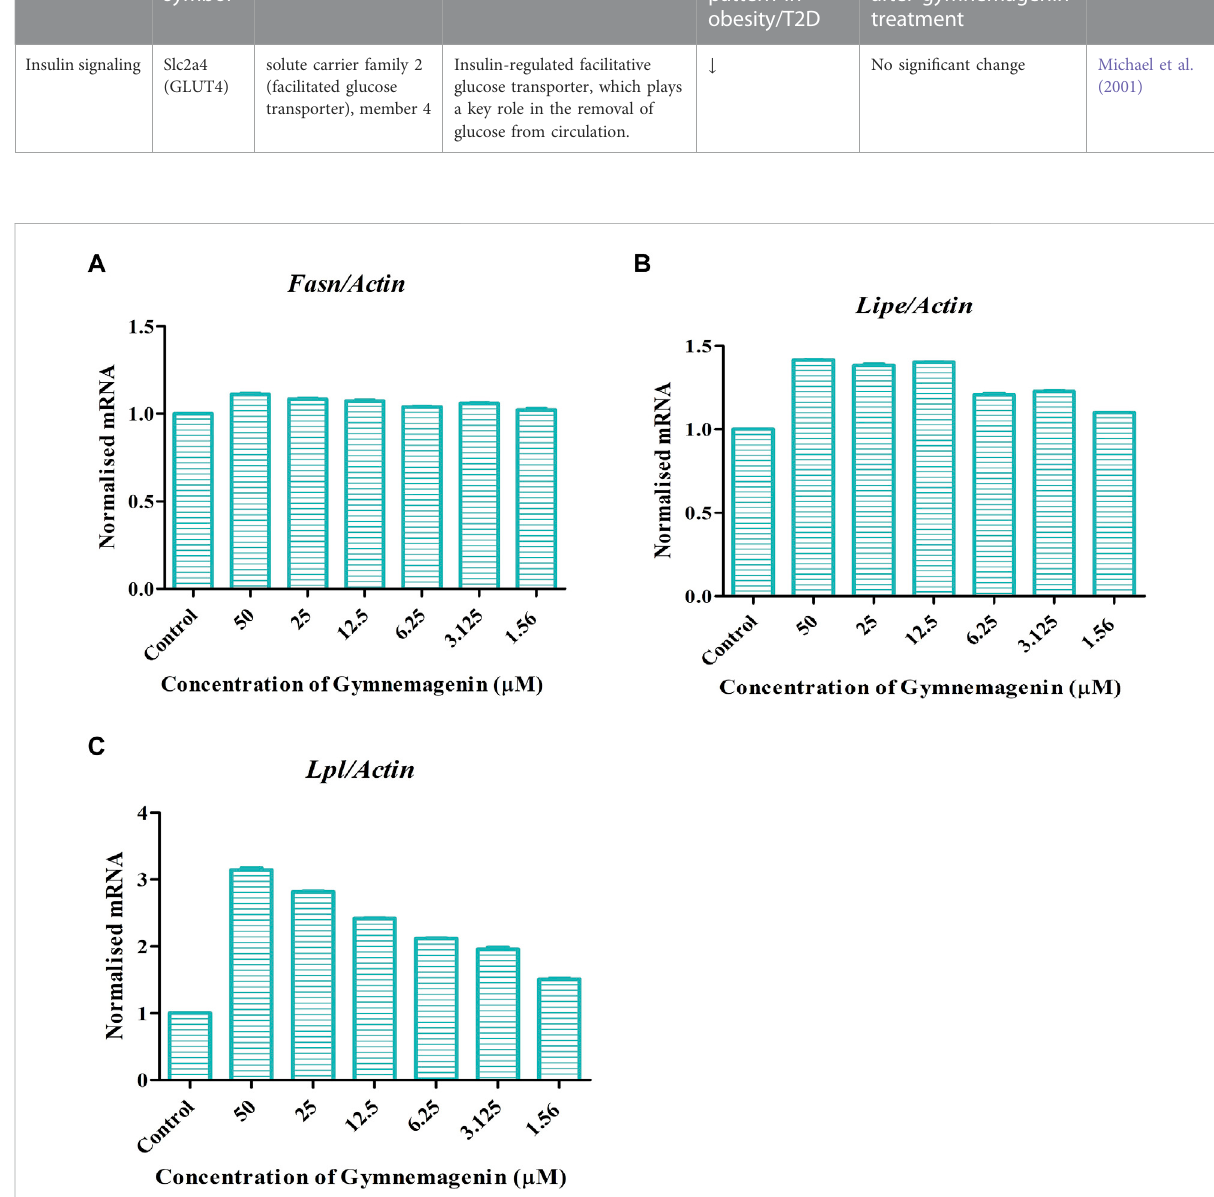
FIGURE 3 Effect of gymnemagenin treatment on lipase enzyme coding genes expressed in 3T3L1 adipocytes. Data represent the mean ± SE. n = 3 per group. (A) Gymnemagenin showed no effect on the expression of Fasn gene, (B) Gymnemagenin showed no effect on the expression of Lipe in treated cells, (C) Gymnemagenin increased the expression of Lpl gene in the treated